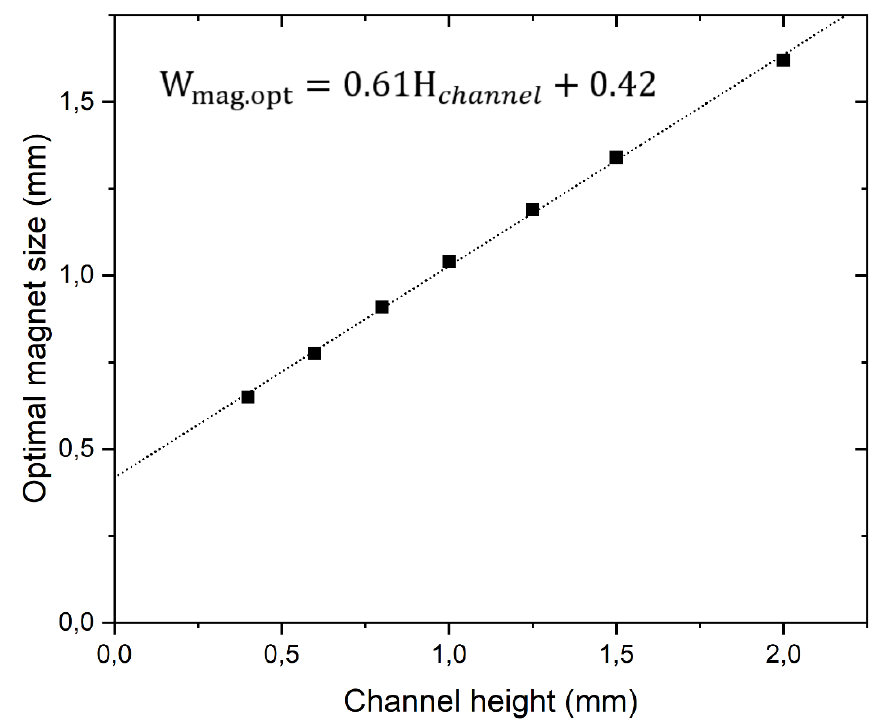
Figure 7. Calculated optimal magnet width for Halbach arrays consisting of 1.5-mm-high elements in flow channels of increasing heights. The optimal width shows a linear relation to the channel height.